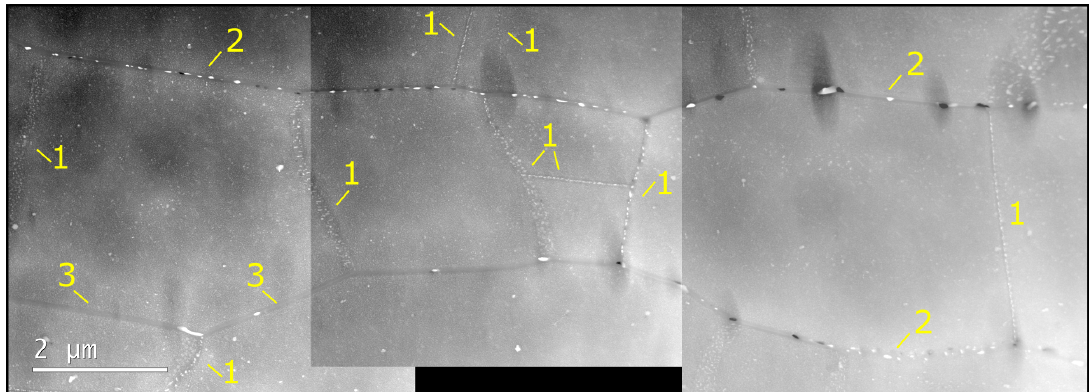
Figure 5. HAADF-STEM image showing the typical microstructure found in TEM. Three distinct types of grain boundaries are observed. (1) Low-angle (< 2 ◦ ) sub-grain boundaries with high number densities of particles. (2) Grain boundaries with fewer, but larger particles, and (3) grain boundaries with no or very few particles. The image is acquired parallel to the extrusion direction for sample H-AC-T7. Similar observations were made in all